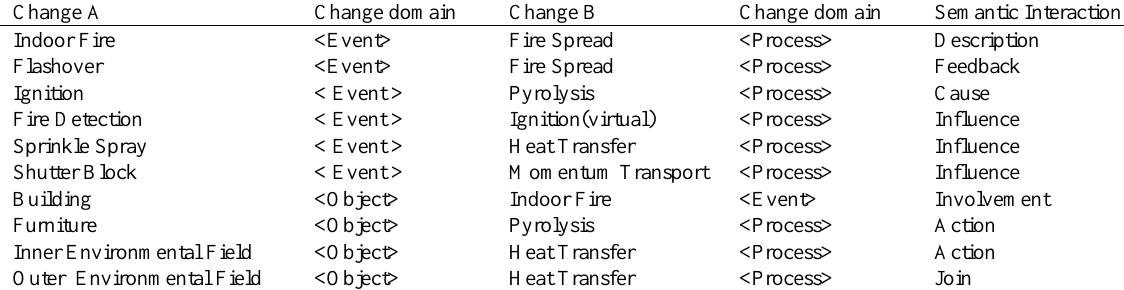
Table 1. Typical semantic interactions between the changes in indoor fire disaster